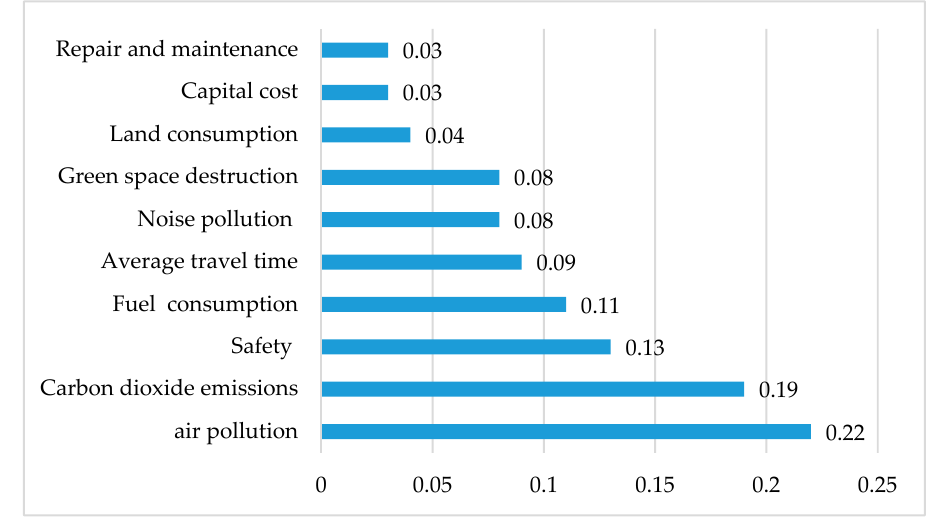
Figure 5. The weight of sustainable indicators based on the expert’s point-of-view (overall inconsistency 0.06).